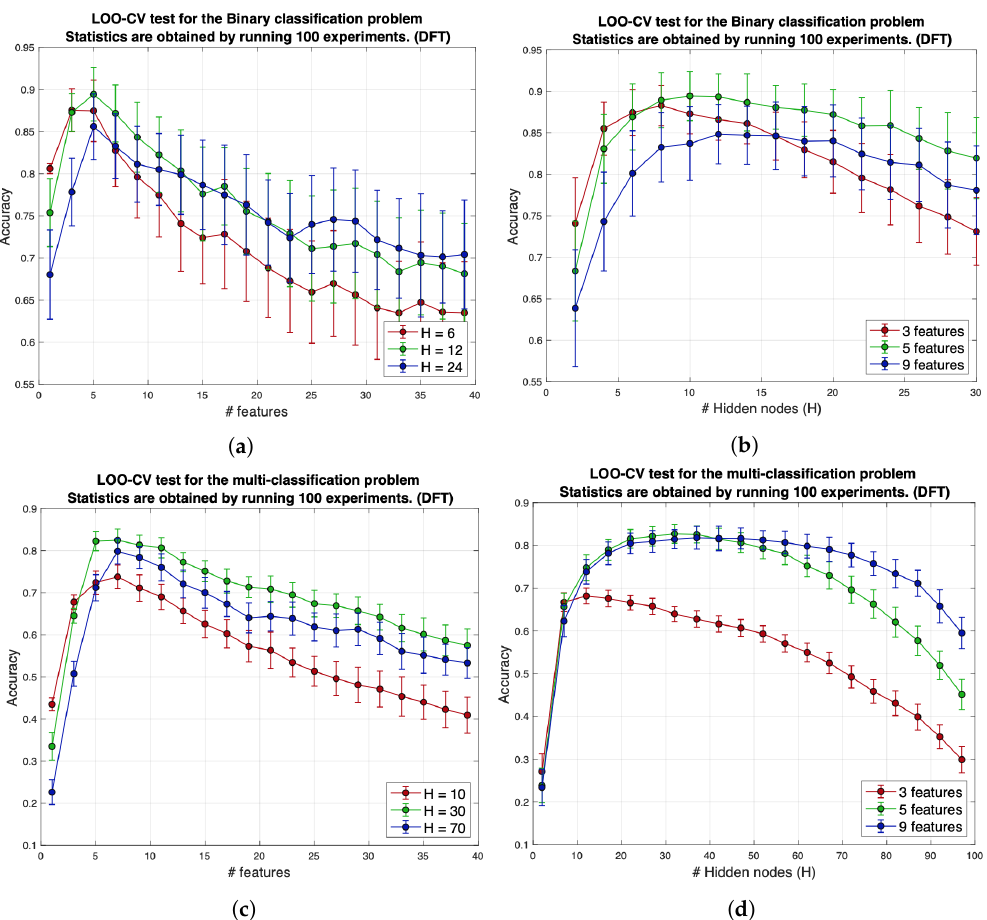
Figure 9. The accuracy obtained by training a single-hidden layer feed-forward neural (SLFN) with the DFT-based features. Leave-one-out cross-validation